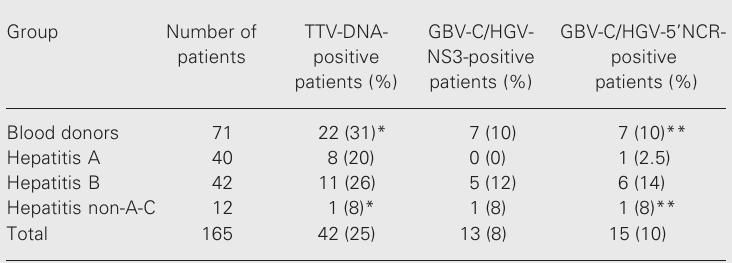
Table 2. Prevalence of serum TTV-DNA and GBV-C/HGV-RNA in patients with acute hepatitis and in blood donors.